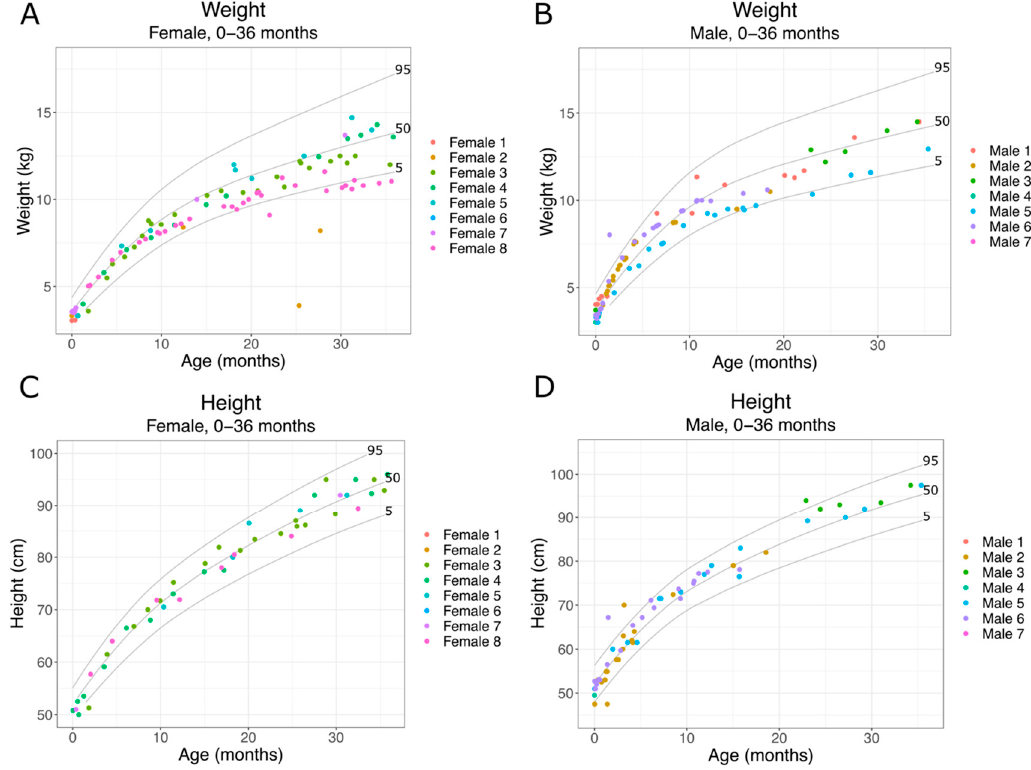
Figure 2 . SLC13A5 Citrate Transporter Disorder patient weight 0–36 months: ( A ) weight of female patients 0–36 months; ( B ) weight of male patients 0–36 months; ( C ) height of female patients 0–36 months; ( D ) height of male patients from 0–36 months. Each panel includes the 95th, 50th and 5th percentiles from the CDC growth charts.